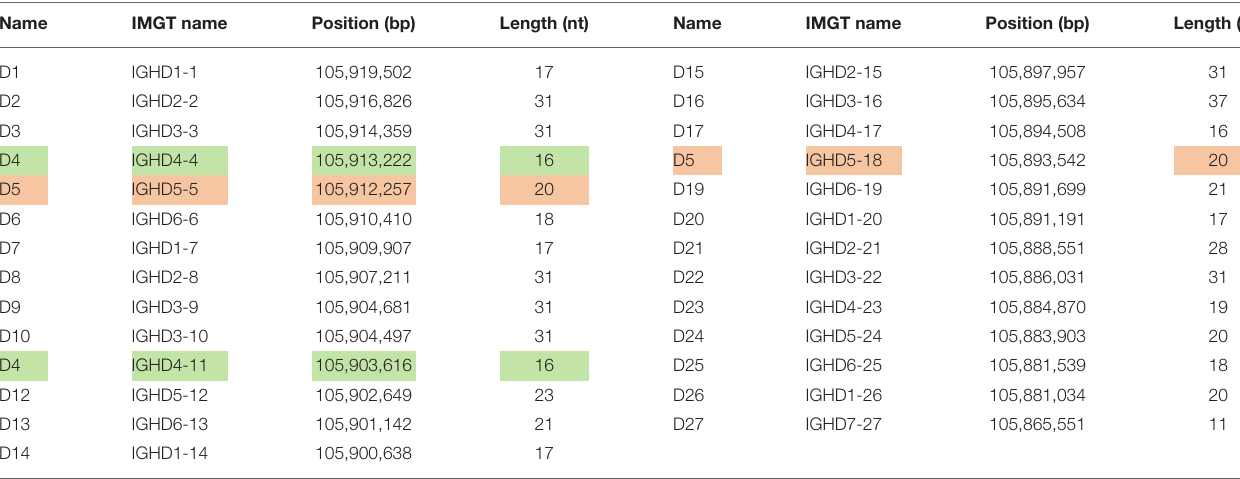
TABLE 1 | Positions and lengths of human D